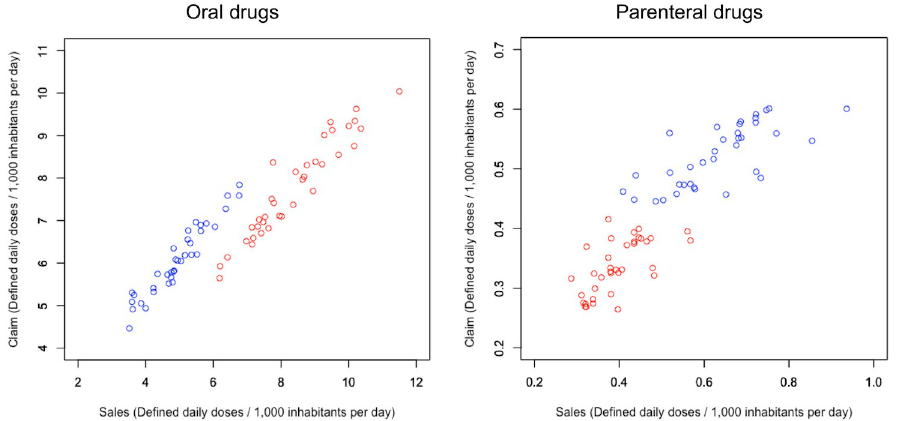
Fig 3. Relationship between S-AMU and C-AMU in terms of oral vs. parenteral drugs. Coefficients ( P value) and adjusted R squared values for oral drugs were 0.90 ( P < 0.001), 0.92 in generic drugs, and 0.84 ( P < 0.001), 0.91 in branded drugs, and for parenteral drugs, were 0.32 ( P < 0.001), 0.43 in generic drugs, and 0.52 ( P < 0.001), 0.40 in branded drugs.